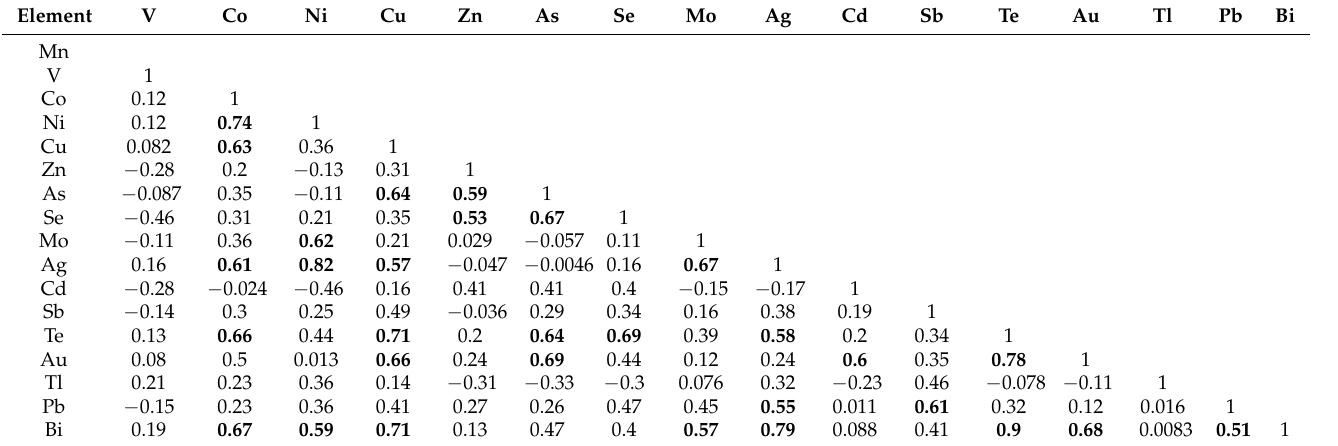
Table 7. Pearson coefficients of correlation of trace elements in late generations of